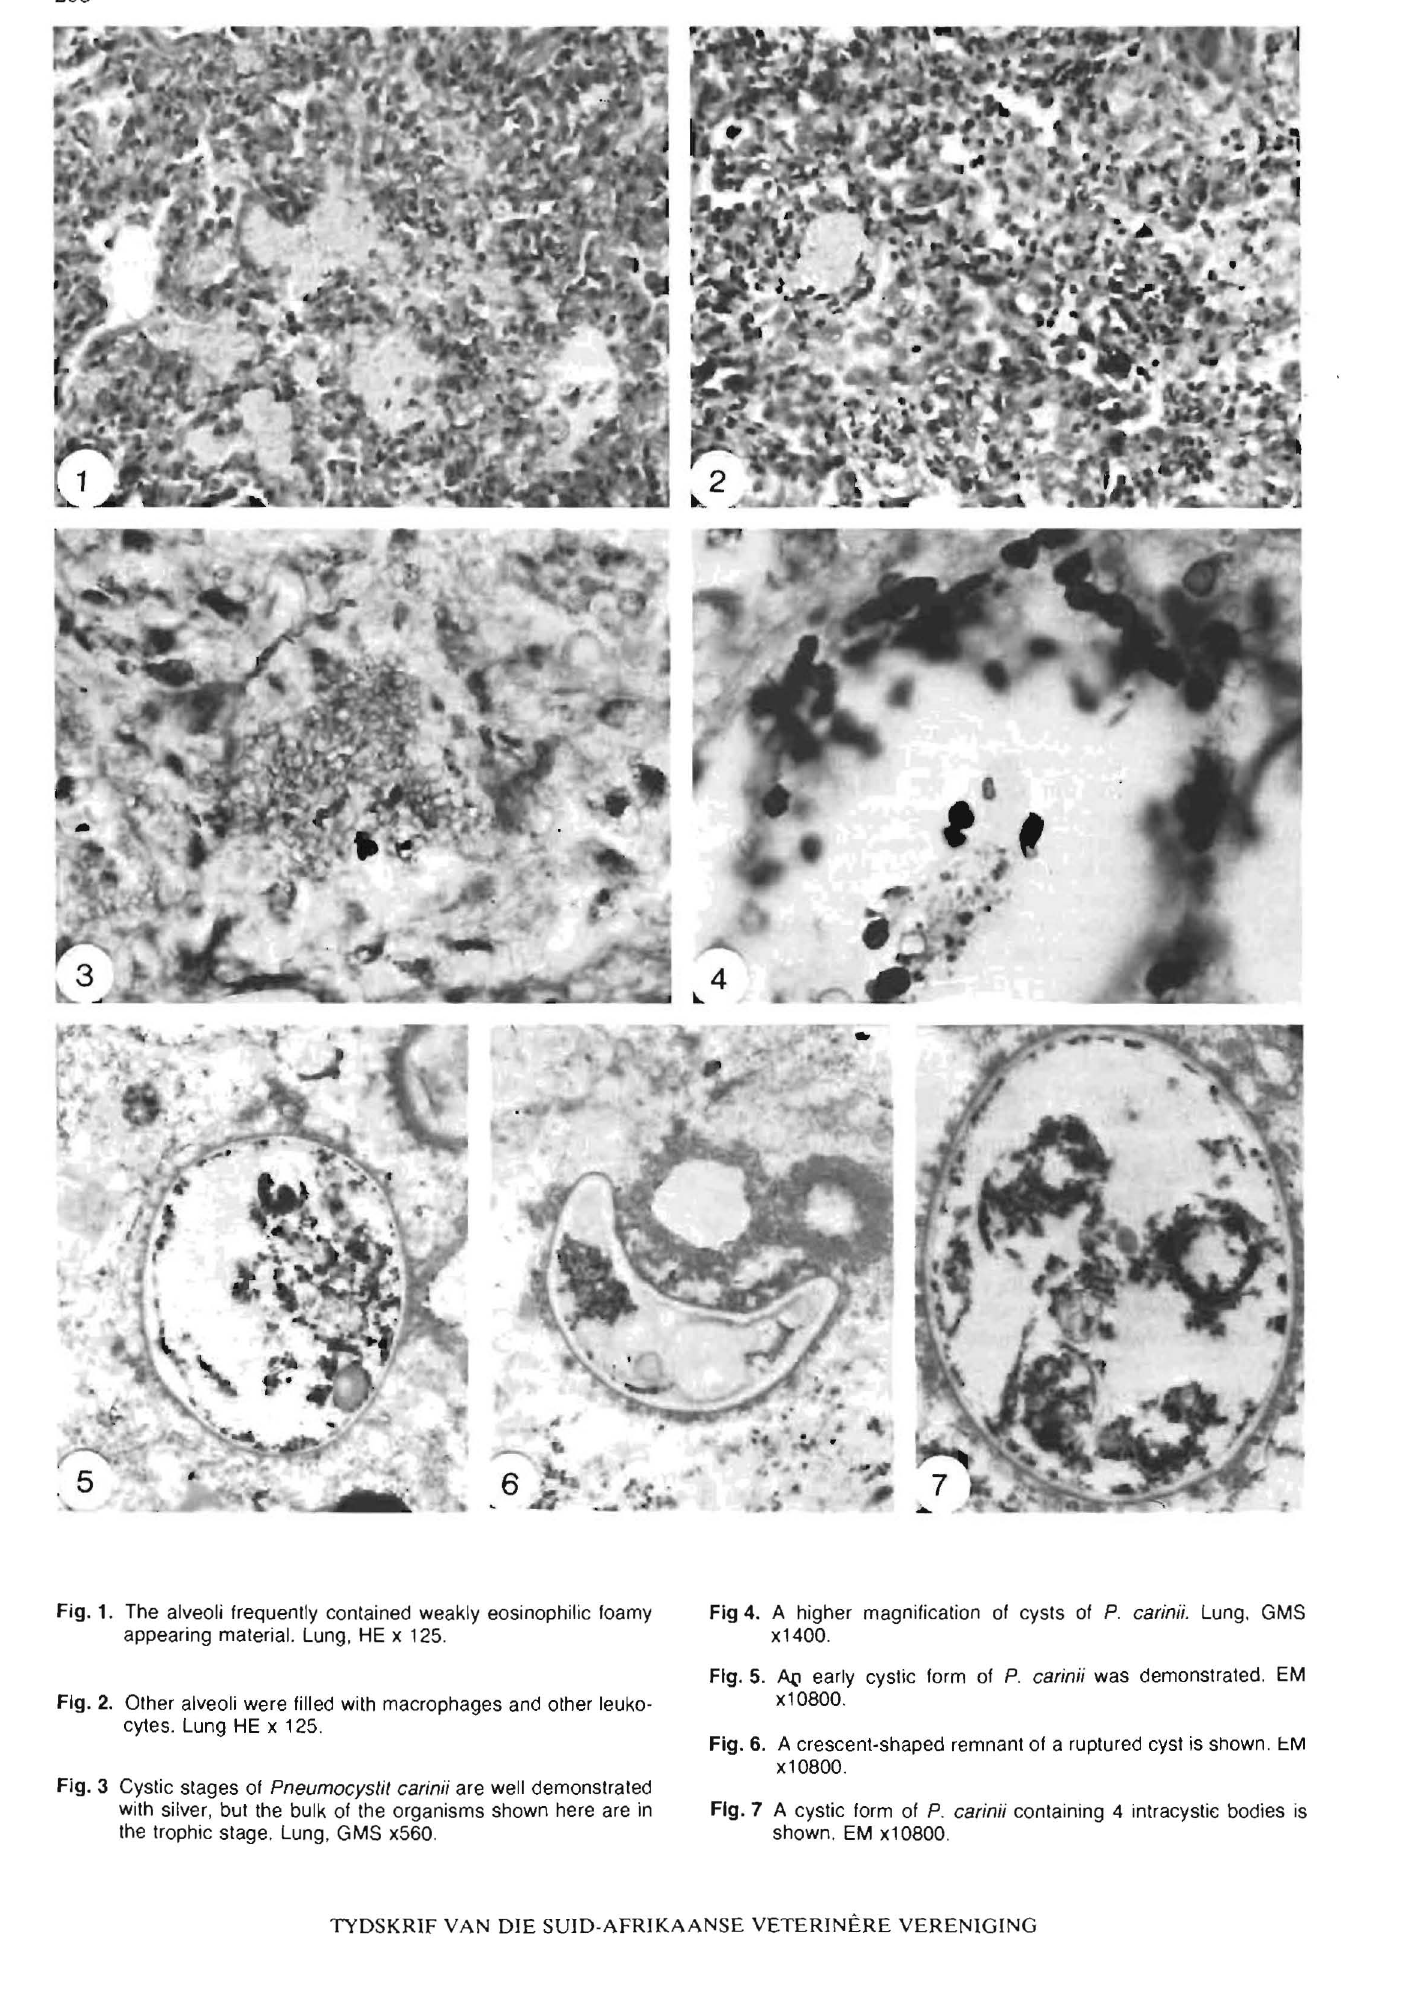
Fig 4. A higher magnification of cysts of P. carinii. Lung. GMS x1400. Fig. 5. A{1 early cystic form of P. carinii was demonstrated. EM x10800. Fig. 6. A crescent-shaped remnant of a ruptured cyst is shown. eM x10800. Fig. 7 A cystic form of P. carinii containing 4 intracystic bodies is shown. EM